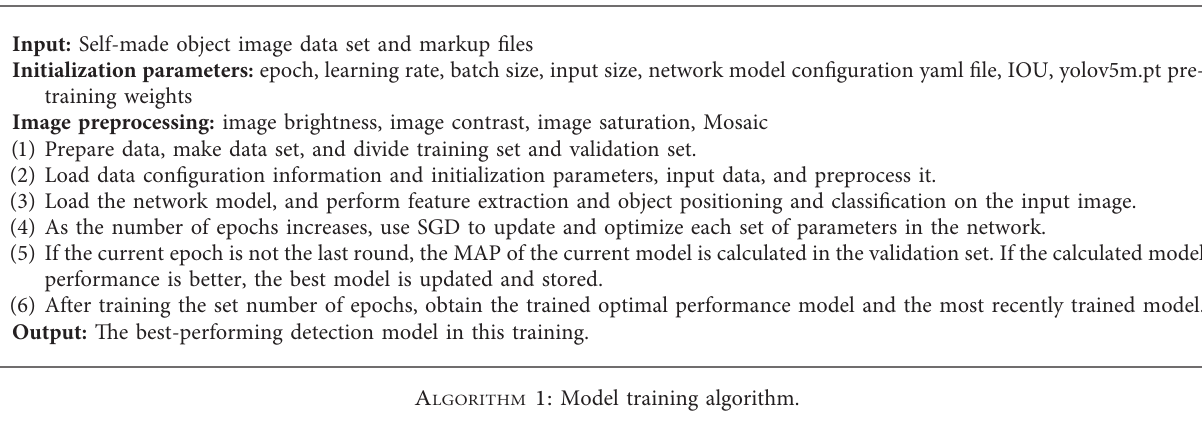
Table 1: Network parameter description